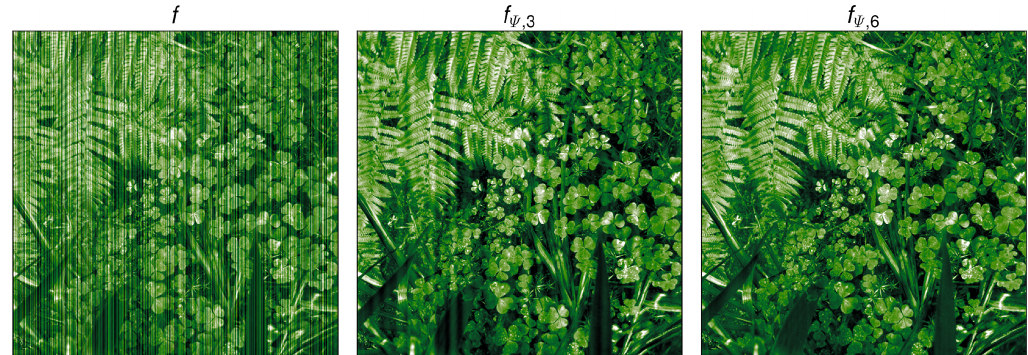
Figure 15. Performance of the combined wavelet–Fourier filter using coiflet wavelets (coif16), σ = 2, and different decomposition levels L